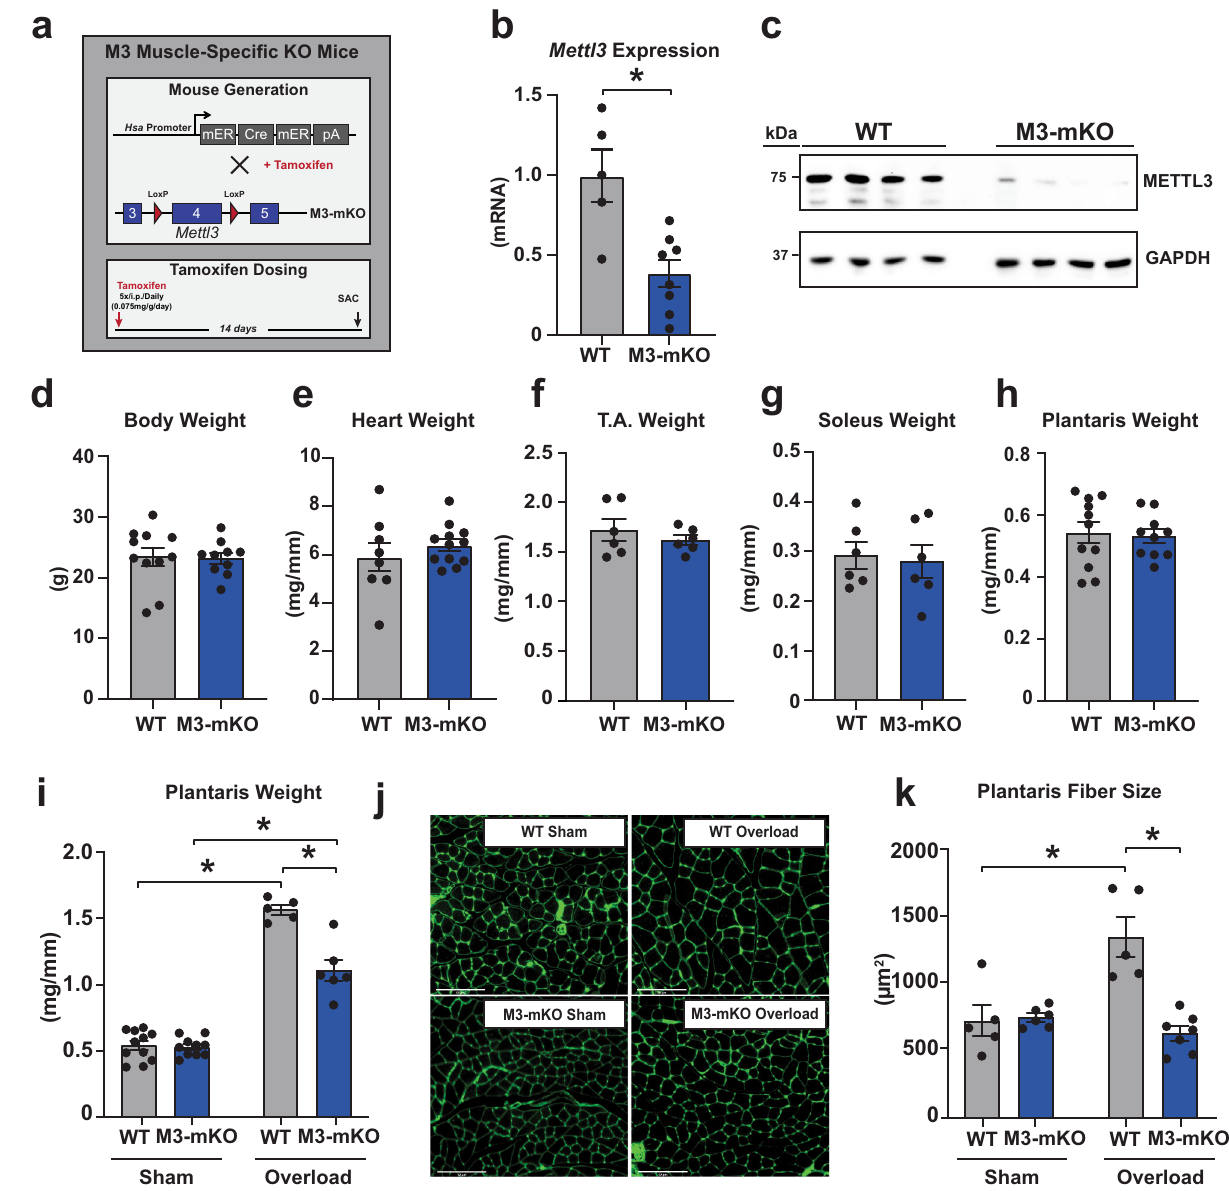
Fig. 2 METTL3 is essential for the growth response of muscle. a Schematic of muscle-speci fi c METTL3 knock out (M3-mKO) mouse generation. b qPCR analysis of Mettl3 mRNA expression in the plantaris muscles of WT and M3-mKO mice. c Western blot of METTL3 protein expression and GAPDH loading control in WT and M3-mKO muscles. d Body weight, e heart weight, f tibialis anterior (T.A.) weight, g soleus weight, and h plantaris weight in WT and M3- mKO mice 2 weeks post tamoxifen injections to induced muscle-speci fi c deletion of Mettl3 . Tibia length (TL) was used to normalize cardiac and skeletal muscle weights. i Plantaris weight, j representative wheat germ agglutinin (WGA; green) stained images and k plantaris fi ber size at baseline or 14 days after synergist ablation surgery in WT and M3-mKO mice. Biological animal replicates: n = 5 (WT) and 8 (mKO) in panel b; n = 11 (WT) and 10 (mKO) in panel d and h ; n = 8 (WT) and 12 (mKO) in panel e ; n = 6 (WT) and 6 (mKO) in panel f and g ; n = 11 (WT sham), 10 (mKO sham), 5 (WT overload), and 6 (mKO overload) in panel i ; n = 5 (WT sham), 6 (mKO sham), 5 (WT overload), and 7 (mKO overload) in panel k . Data are presented as the mean±SEM. * P <0.05, by 2-sided Student ’ s t test for comparisons between WT and M3-mKO mice, or by 2-way ANOVA with Tukey ’ s HSD multiple-comparison test for comparison of the means of WT and M3-mKO mice and baseline and during overload. Scale bar = 125 µ m. Source data are provided as a Source Data fi by METTL3 affects TGF-beta superfamily signaling through in overloaded muscles (Fig. 6b). In this condition, a modest regulation of activin receptor mRNA translation. negative effect on AKT phosphorylation was also observed (Supplementary Fig. 4a), while an additional growth-modulating pathway, forkhead box O-3 (FOXO3), showed more variability (Supplementary Fig. 4b). Anti-hypertrophic SMAD3 transcrip- tional targets, such as Murf1 (muscle-speci fi c ring fi nger protein 1) and Mafbx (muscle-atrophy F-box protein) were increased in lighted the role of METTL3 as a post-transcriptional regulator METTL3-de fi cient muscles (Fig. 6c, d). Thus, formation of m 6 A